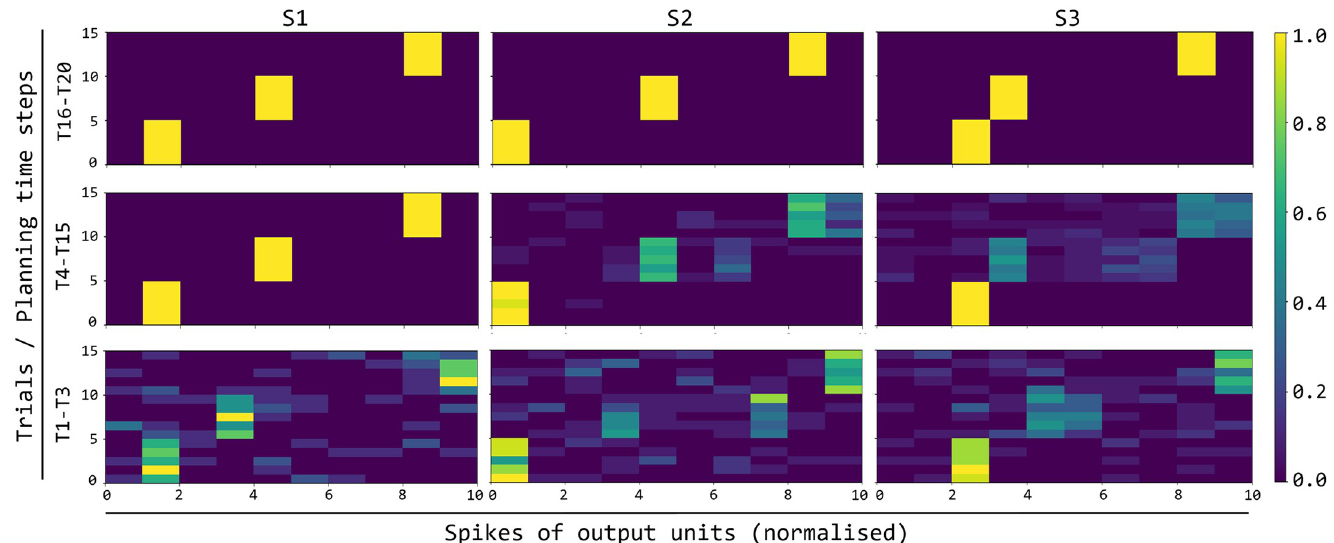
Fig 7. Evolution during trials of the activation of the output layer units encoding the predicted observations and actions. The three columns of graphs refer to the three colour stimuli; the three rows of graphs correspond to different succeeding sets of trials of the task (T1-T3, T4-T15, T16-T20). Each of the nine graphs shows the activation of the 10 output units (x-axis: units 1-3 encode the three colours, units 4-8 encode the 5 actions, and units 9-10 encode the correct/incorrect feedback) during the 15 steps of each trial (y-axis). The colour of the cells in each graph indicates the activation (normalised in [0, 1]) of the corresponding unit, averaged over the graph trials (e.g., T1-T3) and the planning cycles performed within such trials.